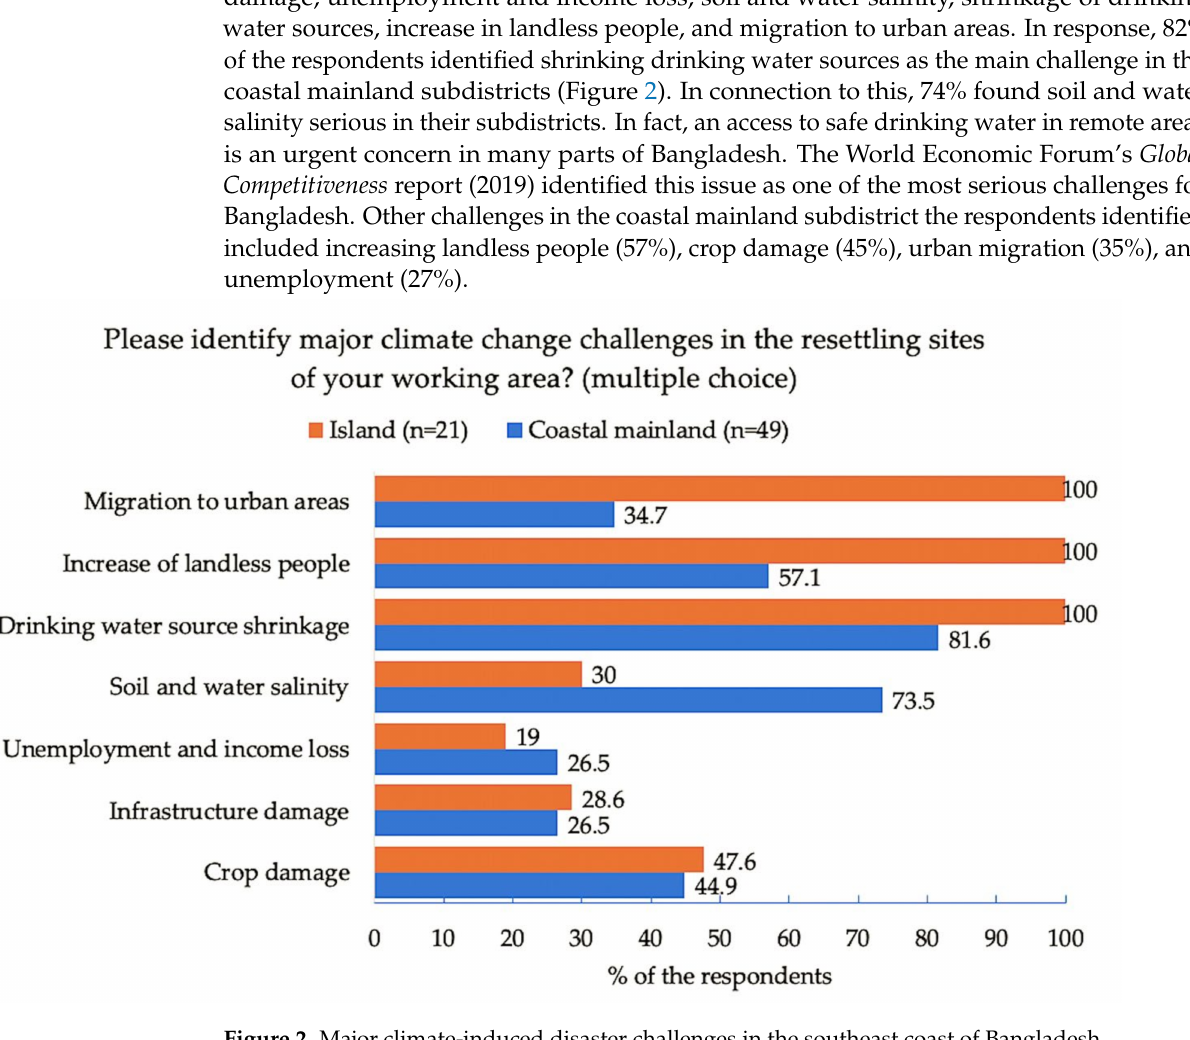
Figure 2. Major climate-induced disaster challenges in the southeast coast of